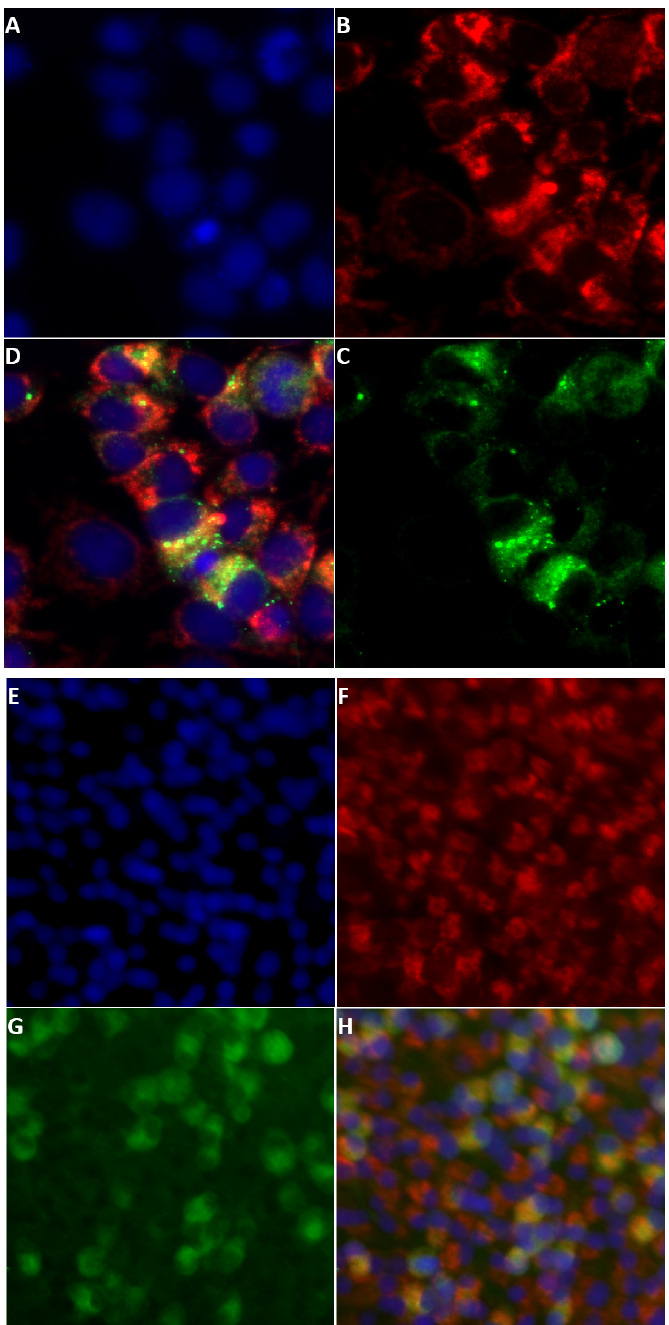
Figure 11. Co-localisation of NS5 with mitochondria in BSR cells infected with BTV-1 or AHSV-4. Infected cells were stained with MitoTracker ® Red CMXRos (red) and probed with mouse anti-NS5 anti-sera and Alexa Fluor 488 conjugated anti-mouse IgG (green fluorescence). Panels ( A – D ): Im- munofluorescence microscopy analysis of BSR cells infected for 24 h with AHSV-4. Panels ( E – H ), BSR cells infected for 24 h with BTV-1. Cells were stained with DAPI ( A , E ), with MitoTracker ® Red CMXRos (red) staining the mitochondrial matrix ( B , F ); probed with anti-AHSV-NS5 antibodies, panel ( C ) (green), or anti-BTV-NS5 panel ( G ) (green). Panel ( D ): merge of ( A – C ); panel ( H ): merge of ( E – G ). Both ( D ) and ( H ) show co-localised NS5 and mitochondria (yellow).